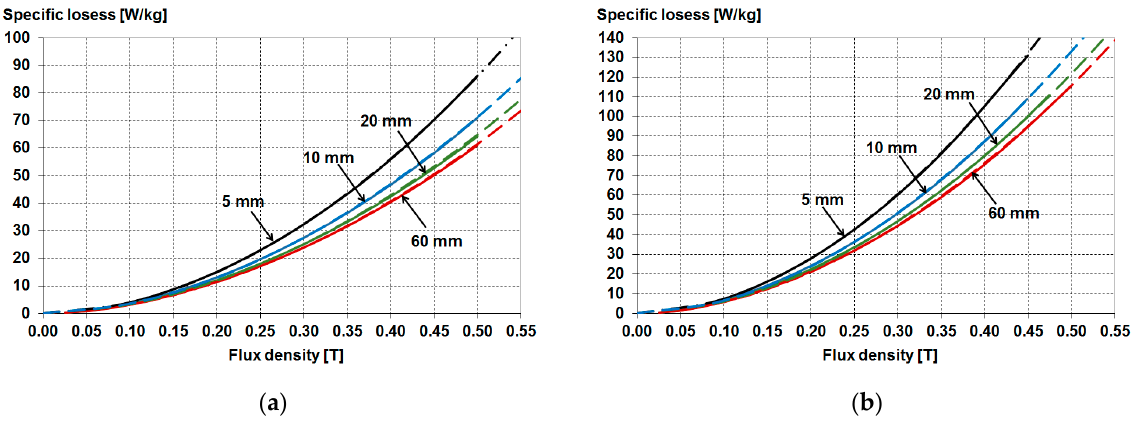
Figure 18. Measured and approximated loss characteristics of the M 270-35A sheet for different widths of the sheet samples, at the frequency of 2000 Hz ( a ), 3000 Hz ( b ); (measured—solid line, estimated—dashed line).